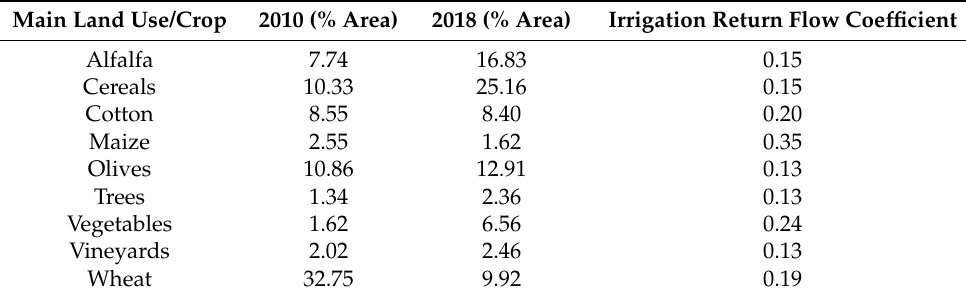
Table 1. Percent land use area irrigated by the Almyros